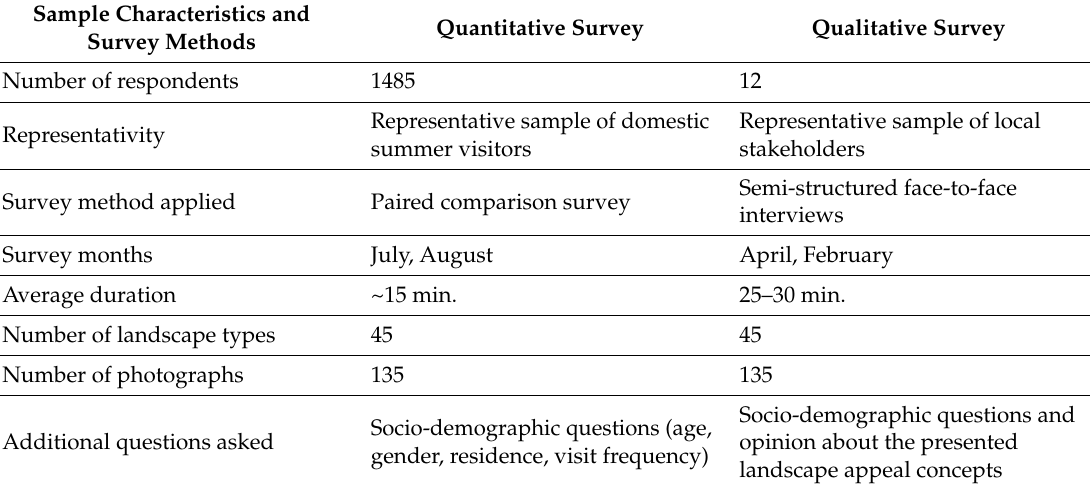
Table 2. The sample characteristics and the survey methods of quantitative and qualitative